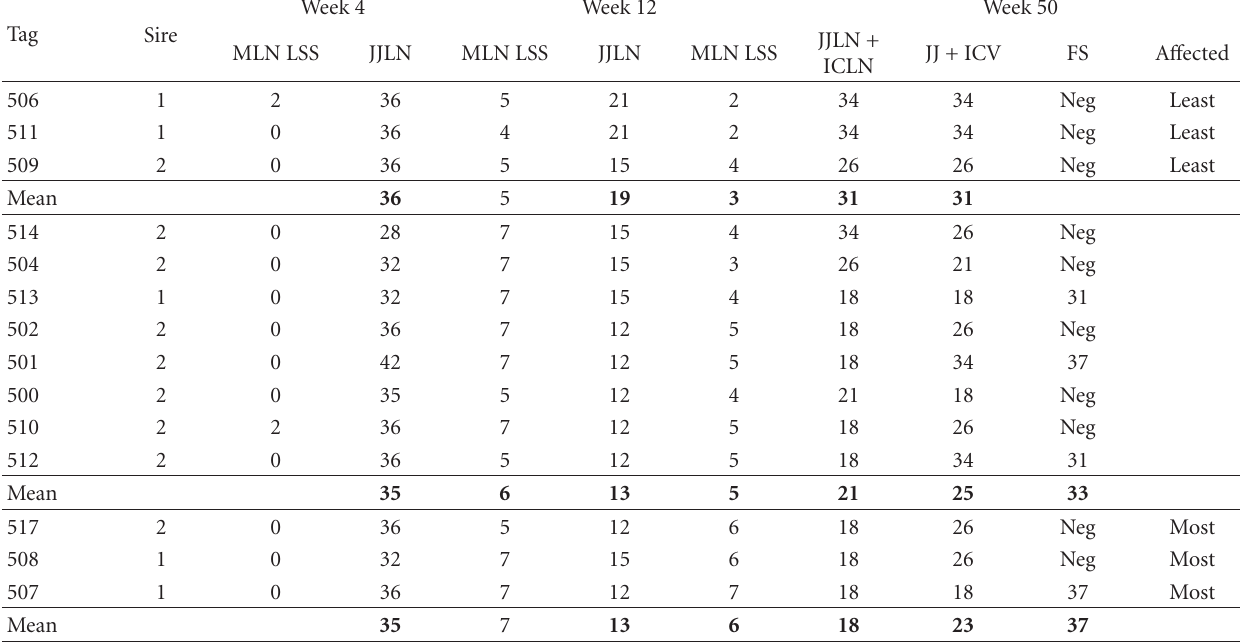
Table 2: Summary of BACTEC culture results in terms of the number of days to positive (dtp) for jejunal lymph node (JJLN) samples taken at Weeks 4 and 12, and for a pool of three samples of JJLN plus ileocaecal lymph node (ICLN) and a pool of three jejunum and ileo-caecal valve samples (JJ + ICV) and faecal samples (FSs) at week 50, compared with MLN lesion severity scores (LSSs) at each time point, with the animals sorted by total LSS at week 50 and designated as least or most a ff